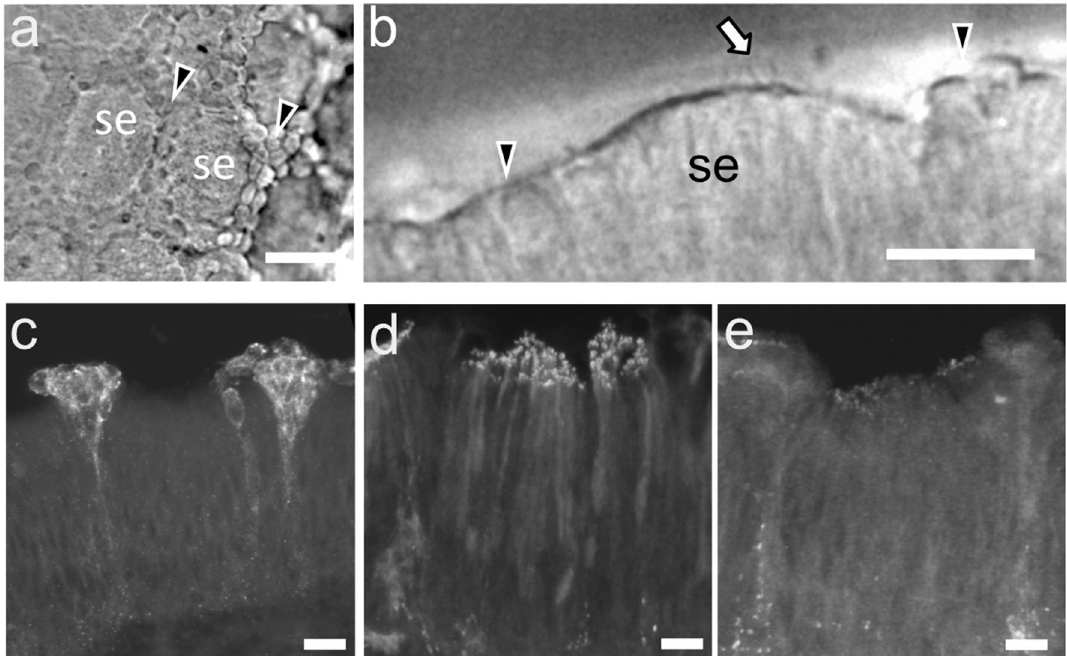
Figure 5. Activity-dependent labeling by pERK antibody labeled oval-shaped cells on the surface of the olfactory epithelium. Differential interference contrast photomicrographs of the surface ( a ) and the edge ( b ) of the olfactory lamella of grass puffer. Arrowheads represent the non-ciliated epithelium surrounding the sensory epithelium “islets” (SE). Arrow represents sensory cilia on the surface of the sensory epithelium. Scale bar = 20 µm. pERK-immunopositive OSNs after exposure to 5,6,11-trideoxyTTX ( c ) or l-Arg ( d ). No labeled cells were observed with the vehicle control ( e ). Scale bar: 5 µm. Six fish examined for each stimulus showed similar